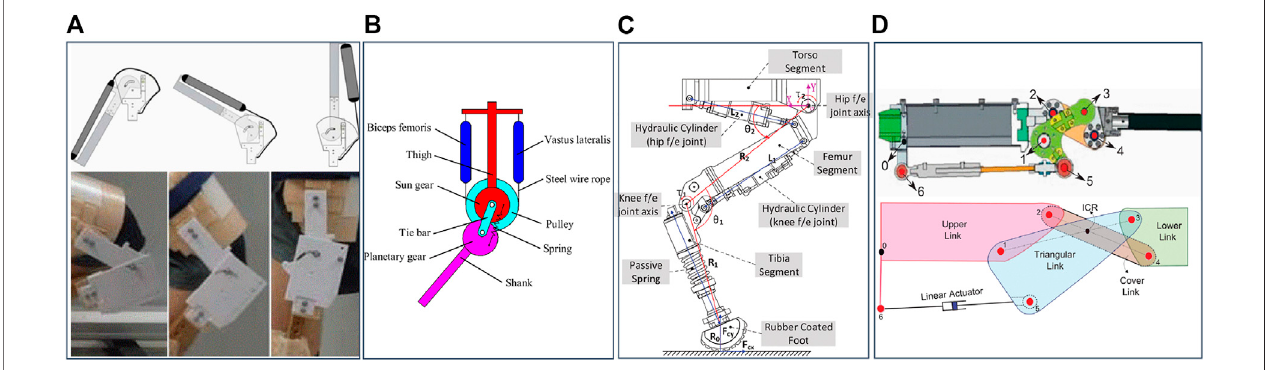
FIGURE 6 | Bio-inspired knee joint based on muscle and ligament structure. (A) Knee joint for power assist suit by Sakai et al. (2015) (B) Knee joint for biped robots by Liu et al. (2016) (C) Articulated robotic leg by Li et al. (2017) (D) Knee joint for quadruped robot by Khan et al. (2015).